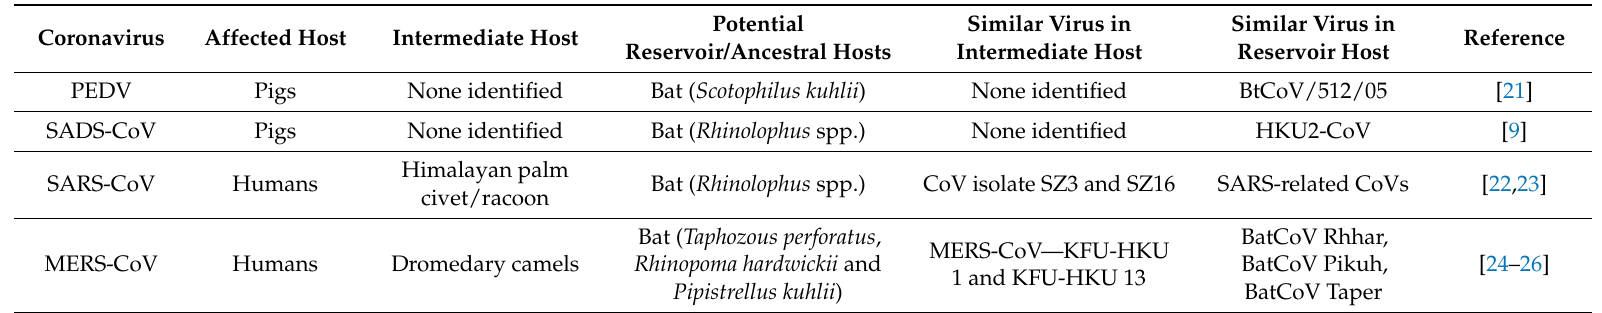
Table 1. Zoonotic coronaviruses that have caused serious disease in humans and agricultural